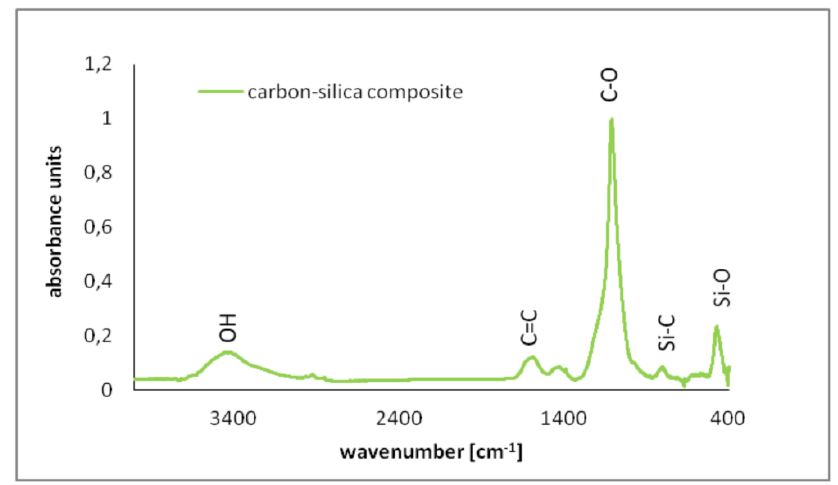
Figure 4. Fourier Transform Infrared Spectroscopy ( FTIR) spectrum of the carbon–silica composite.